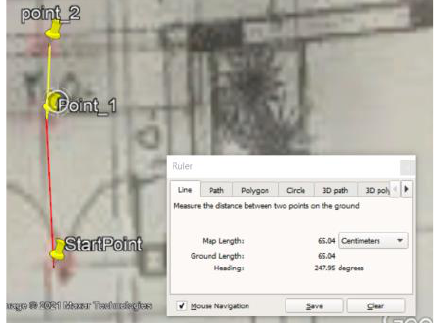
Figure 29. Length and heading to point_2.